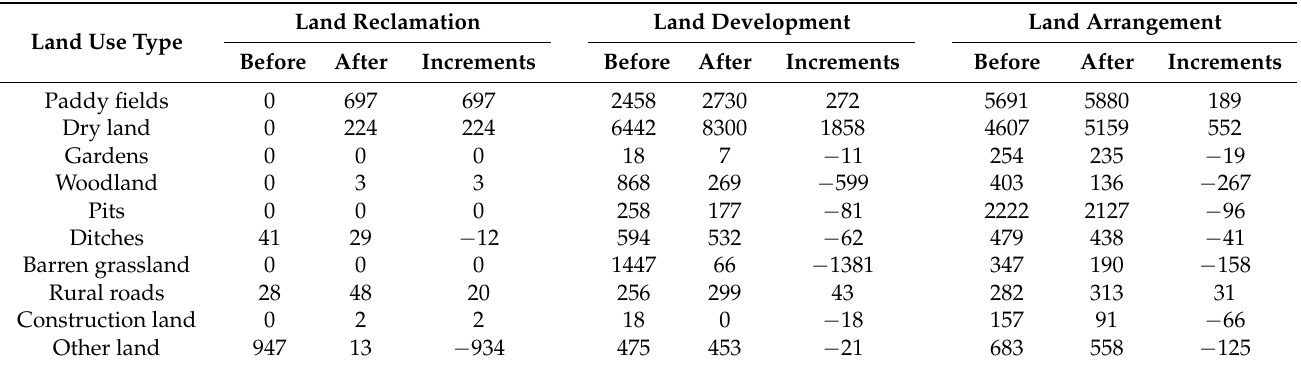
Table 2. Changes in land use area before and after consolidation in typical land consolidation project areas in Hubei province. Unit: hm 2